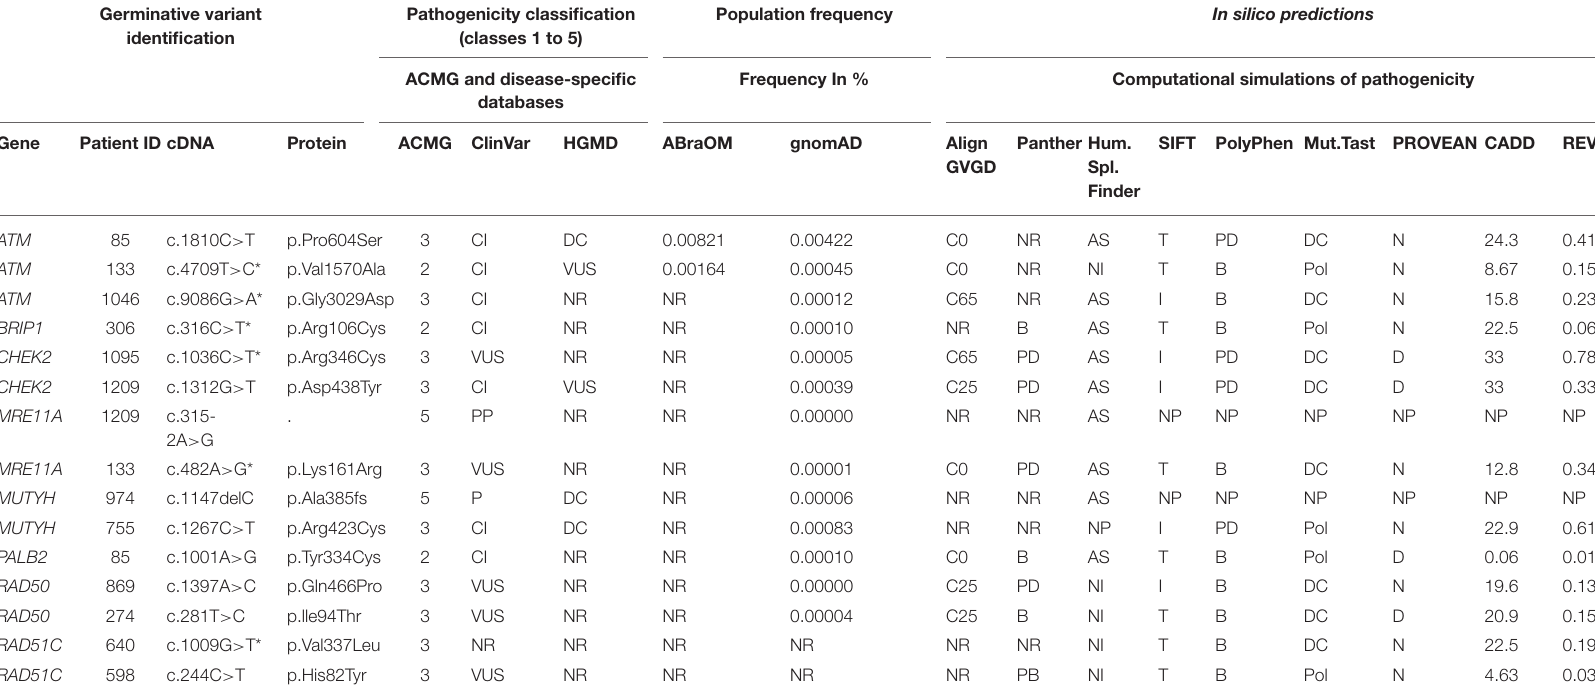
TABLE 2 | Description of the 15 variants identified in the 14-gene